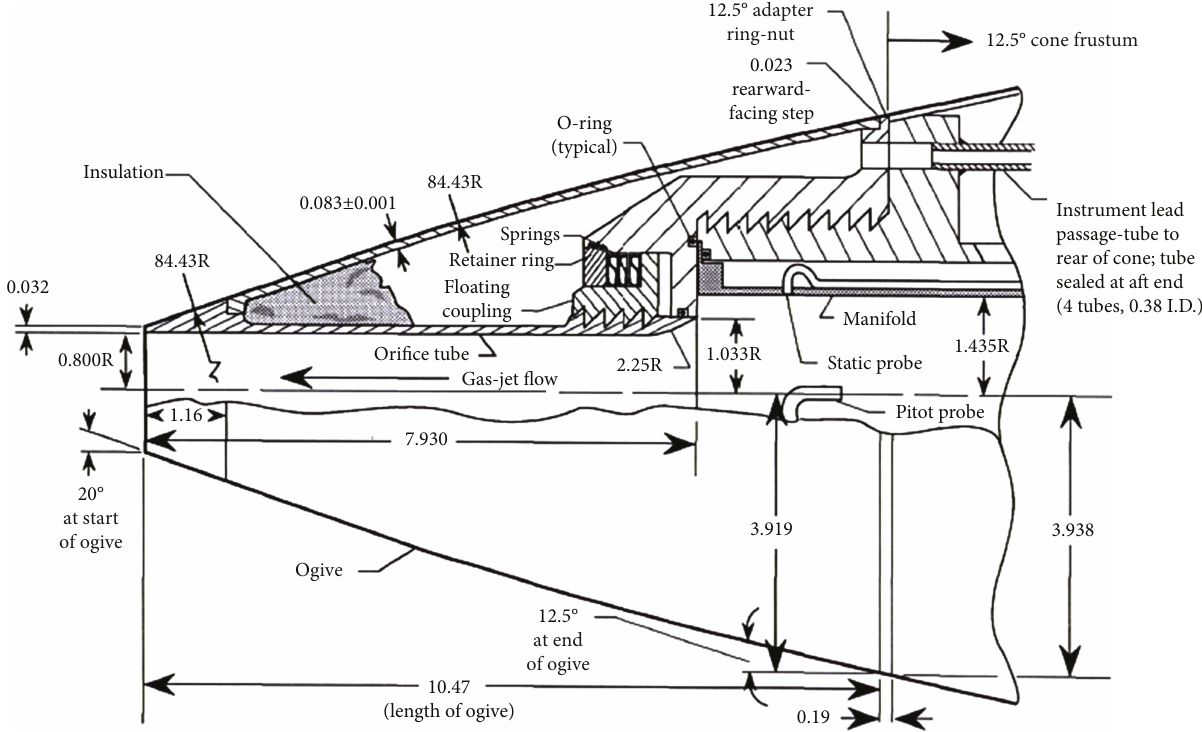
Figure 1: Gasjet frontal blowing model, Nowak